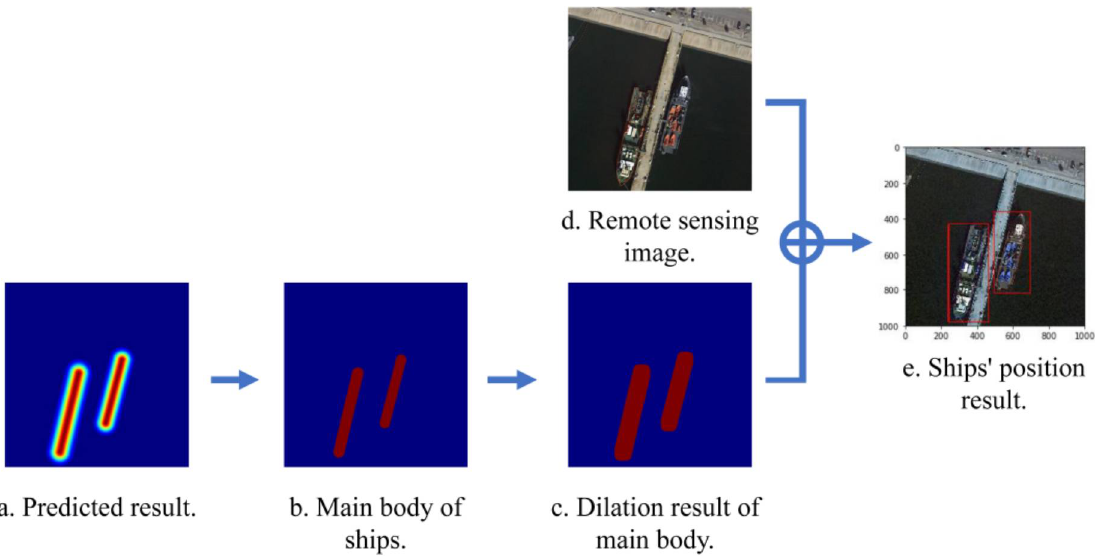
Figure 5. Post-processing.